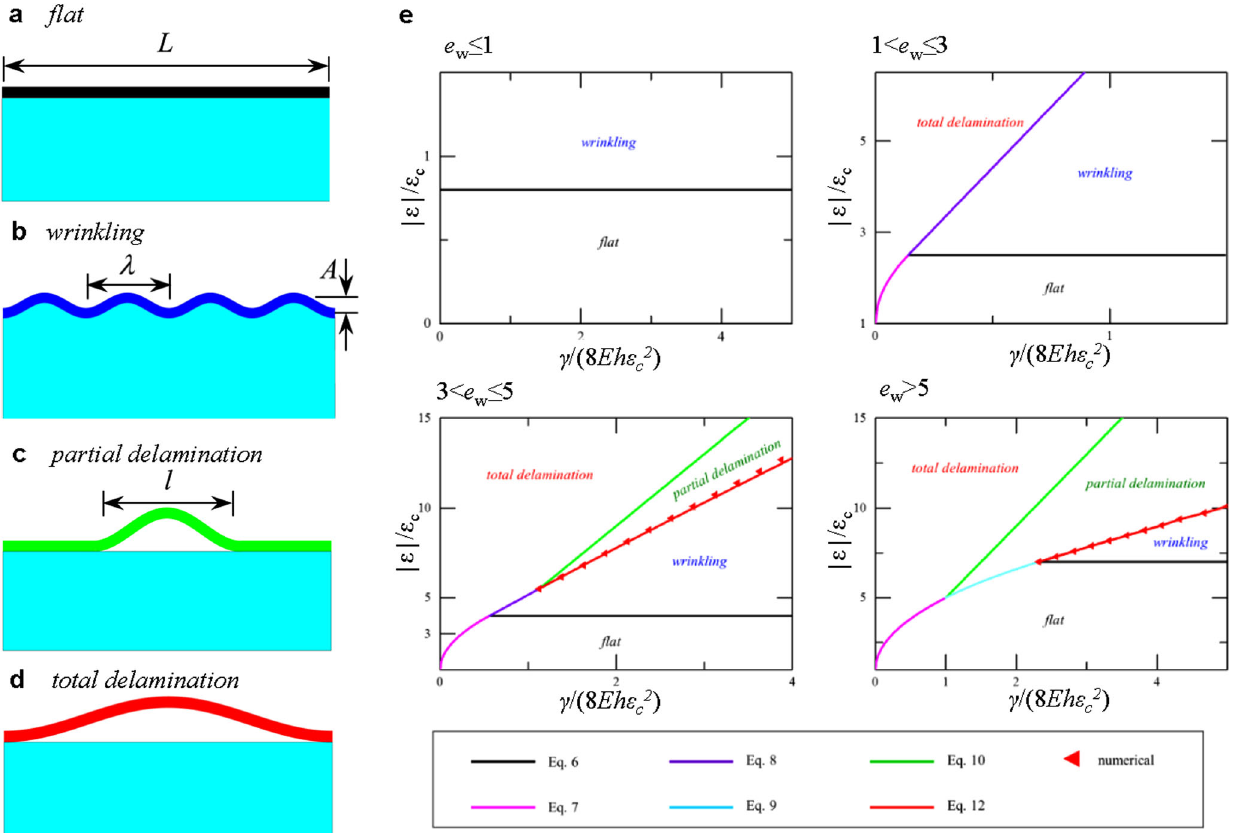
Fig. 6 The four buckling modes a fl at, b wrinkling, c partial delamination, and d total delamination. e Deformation maps that separate the four buckling modes for various values of e w and γ . (Reprinted with permission from ref.